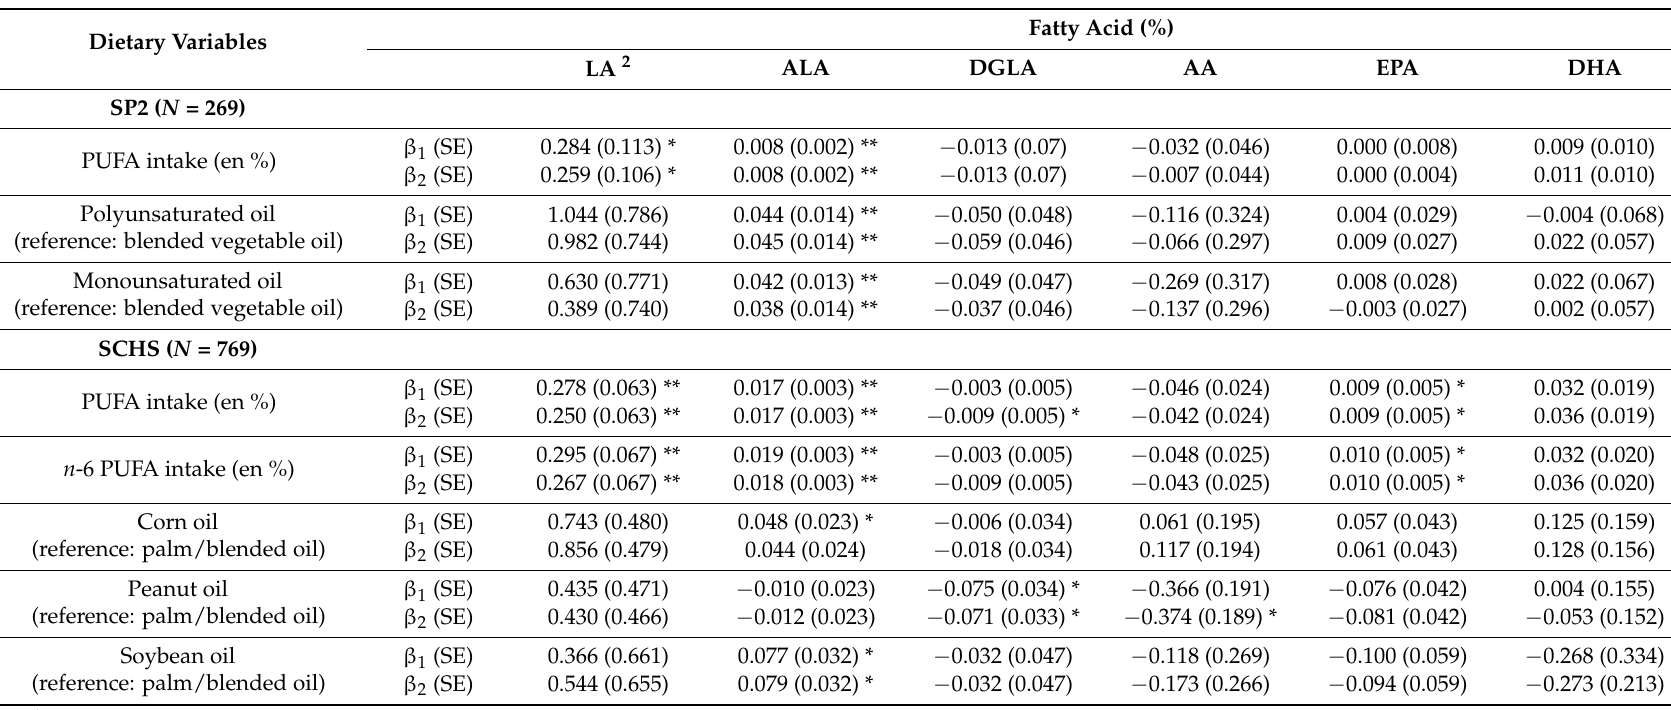
Table 4. Association between polyunsaturated fat (PUFA) and cooking oil intake and plasma fatty acid composition (weight %) of Singapore Prospective Study Program (SP2) and Singapore Chinese Health Study (SCHS) participants 1